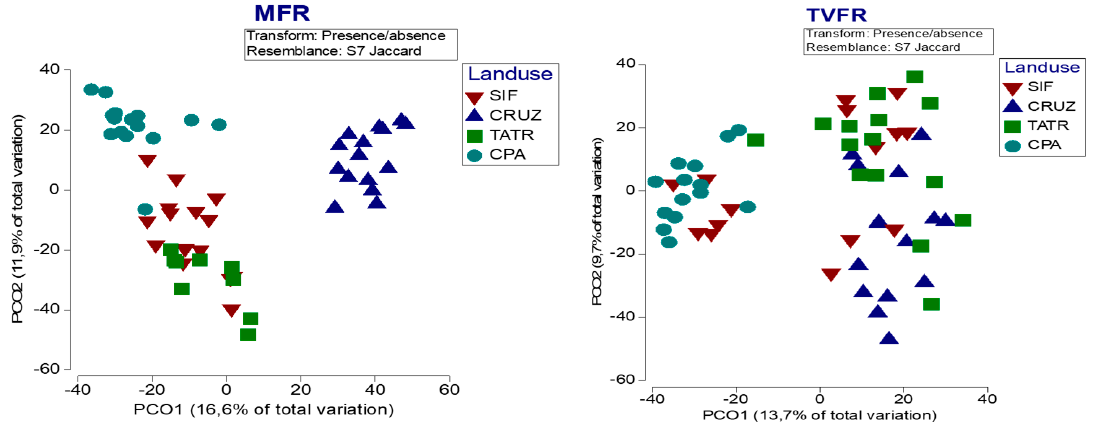
Figure 6. Principal Coordinate analysis (PCO) of local assemblages among different land use regimes within HMFLs and SIF.